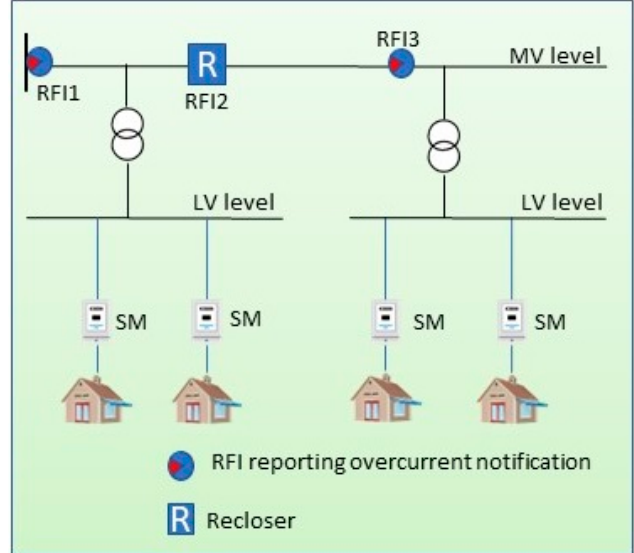
Figure 14. A simplified distribution network [130].